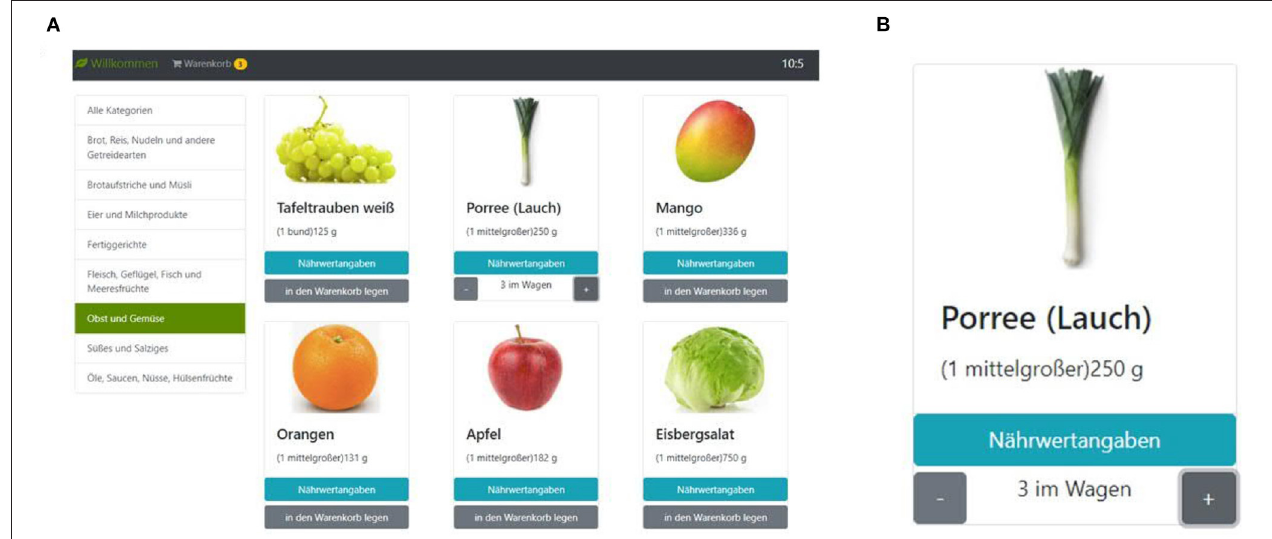
FIGURE 1 | The screenshot of the supermarket task. (A) Participants can choose different food categories shown on the left side to see their items. On the top right corner, the remaining shopping time is presented, and on the left top corner, they can see their shopping basket and modify its content. (B) For each object, participants can see the nutritional values and select how many they wish to put in their basket.